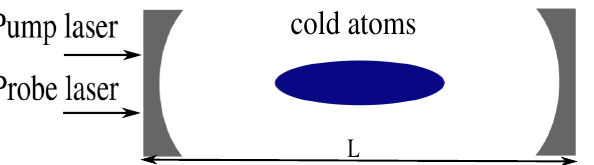
Figure 1. A sample of two-level fermionic atoms with resonant frequency ω a trapped inside a Fabry–Perot cavity of length L . The cavity is simultaneously driven by the strong pump laser field of frequency ω pu and weak probe laser field of frequency ω pr . Here, the left-end mirror is transmissive while the right-end mirror is perfectly